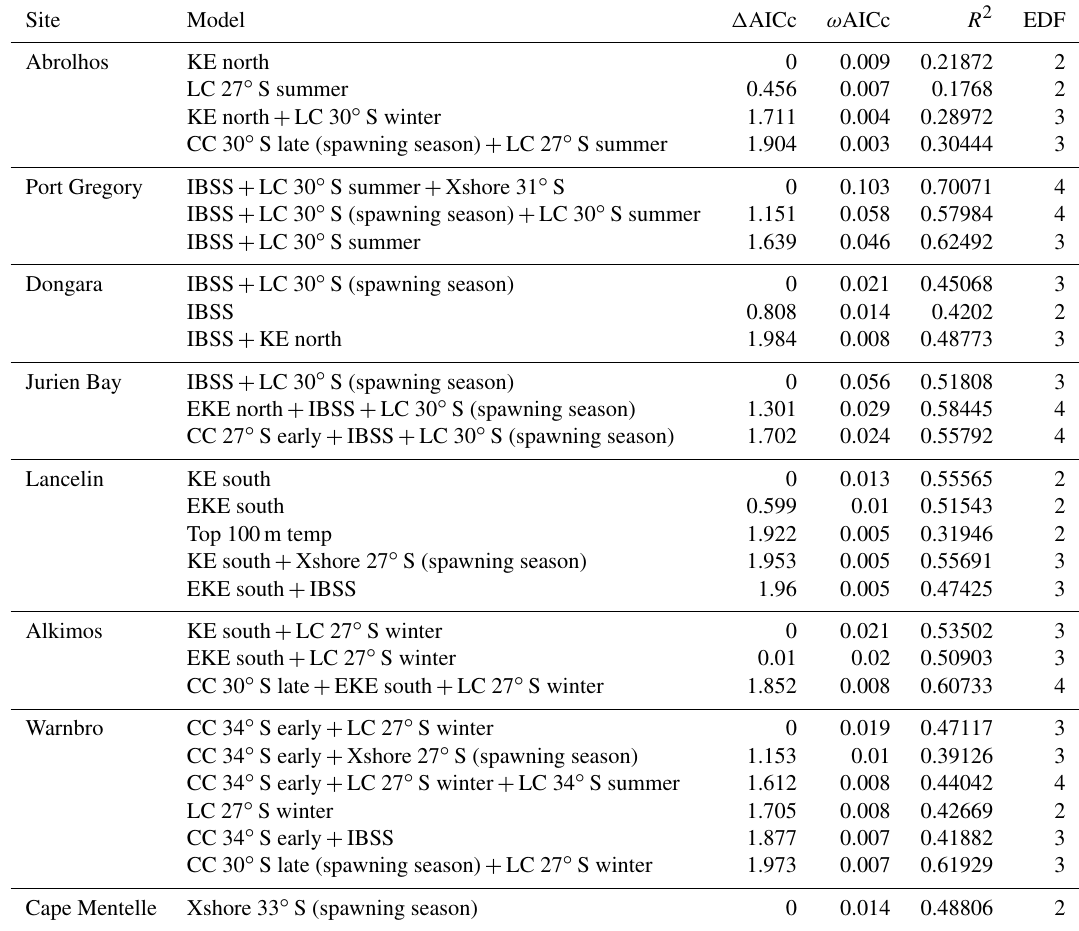
Table B2. Top generalized additive models (GAMs) for predicting the late puerulus settlement at the eight sites from full subset analyses. Differences between lowest reported corrected Akaike information criterion ( (cid:49) AICc), AICc weight ( ω AICc), variance explained ( R 2 ), and effective degrees of freedom (EDF) are reported for model comparison. Model selection was based on the most parsimonious model (fewest variables) within two units of the lowest AICc, and models are ordered by